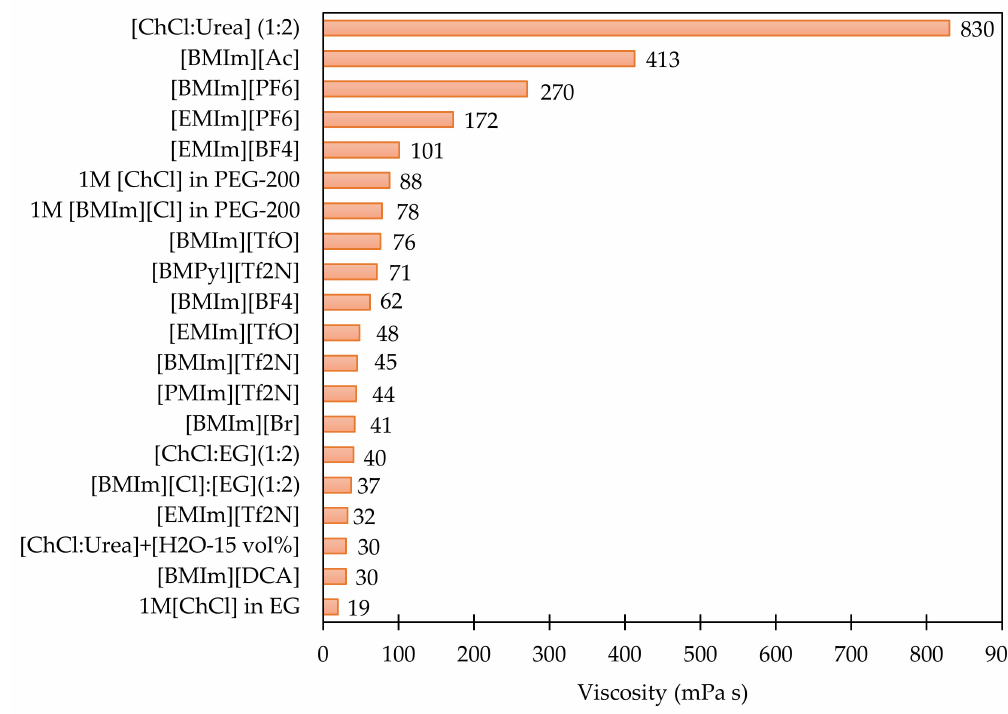
Figure 5. Plot comparing the viscosity of the ILs, DESs that are used in electrochemical conversion of CO 2 at 298